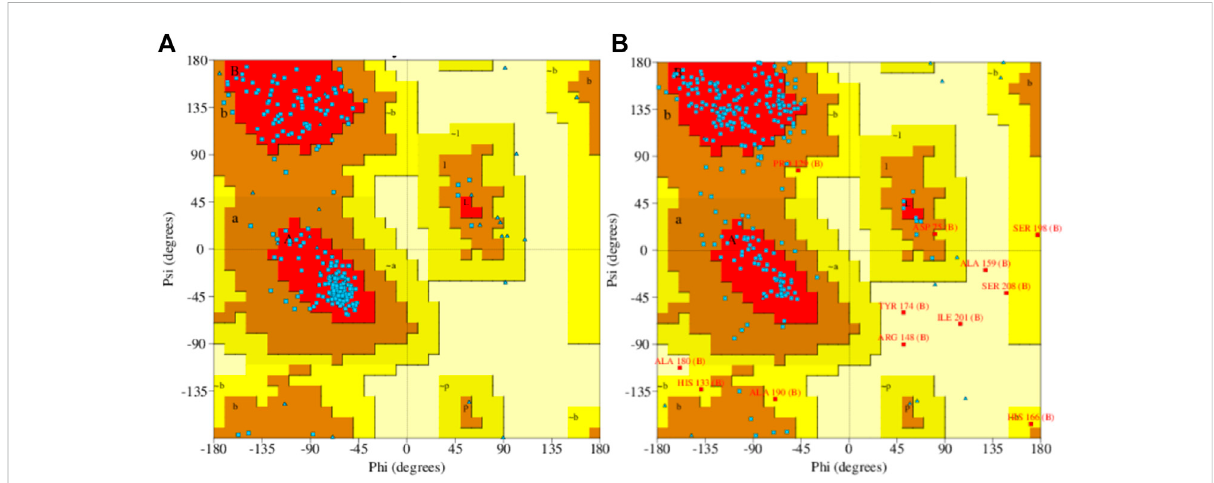
FIGURE 5 Ramachandran plot of predicted 3D structures of THR (A) and VelB (B) proteins of C. lunata using PROCHECK software.